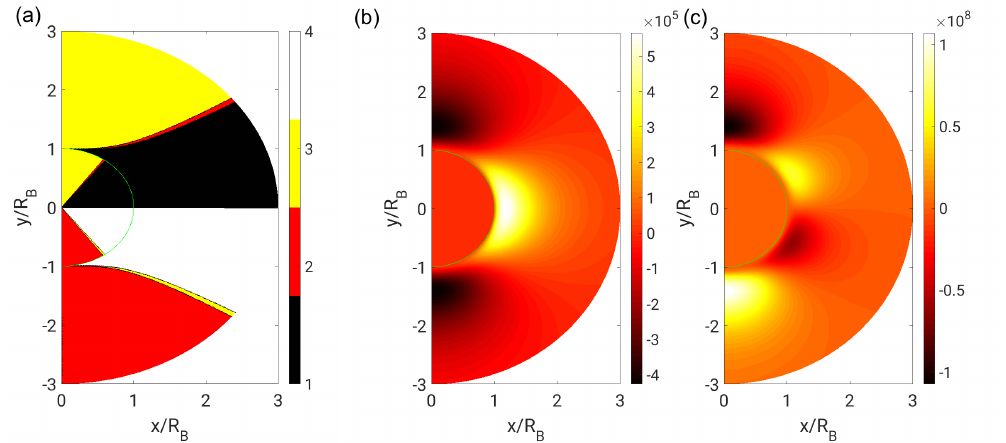
Figure 7. ( a ) Flow topologies; ( b ) second invariant Q ; and ( c ) third invariant R in the droplet case ( ξ = 54.9583) with far-field boundary